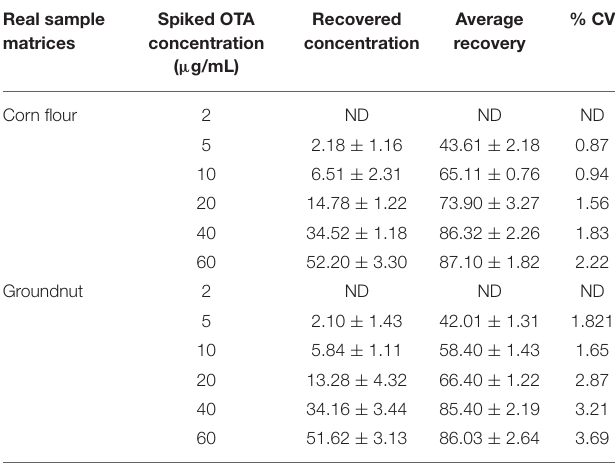
TABLE 2 | Recovery of OTA from spiked corn flour and groundnut samples using